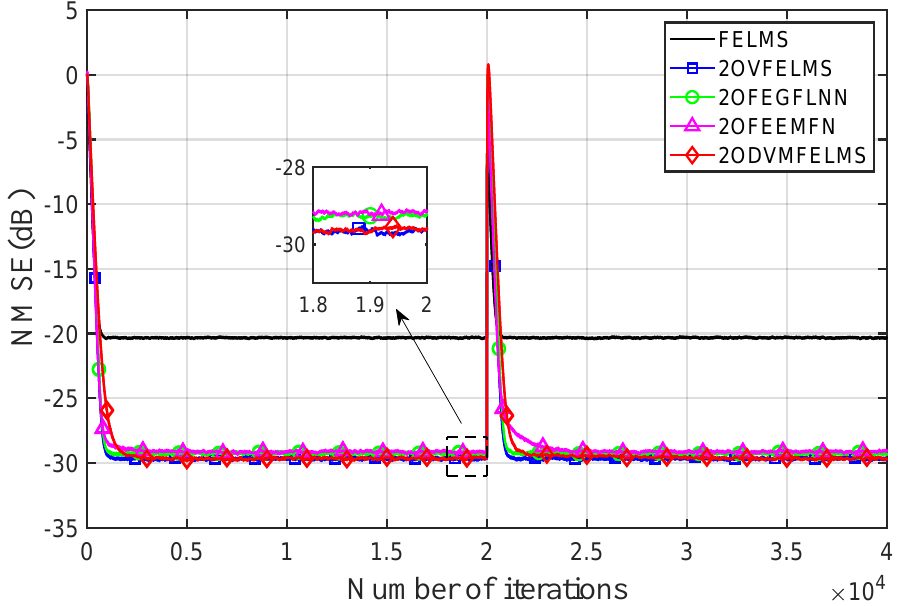
Figure 6. Performance comparison using the nonlinear primary path and secondary path with sinusoidal reference